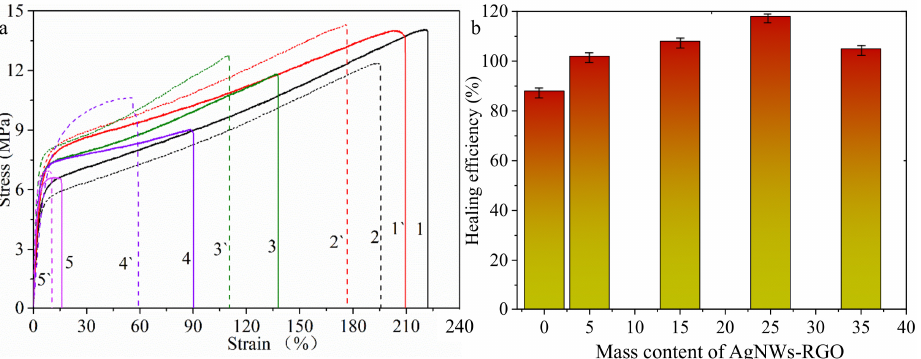
Figure 13. Stress–strain curves ( a ) of composite films with different AgNWs-RGO mass contents before (1–5) and after (1 (cid:48) –5 (cid:48) ) healing and self-healing efficiencies ( b ) of the composite films. (1, 1 (cid:48) ) 0 wt%; (2, 2 (cid:48) ) 5 wt%; (3, 3 (cid:48) ) 15 wt%; (4, 4 (cid:48) ) 25 wt%; (5, 5 (cid:48) ) 35